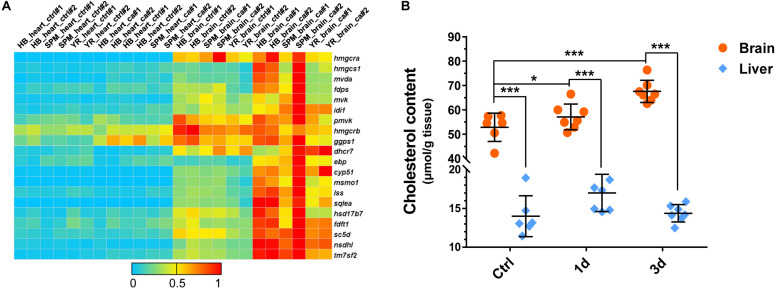
Enhanced total cholesterol accumulation in the brain of common carp during cold acclimation. (A) Up-regulation of genes involved in the cholesterol biosynthesis pathway upon cold stress. The color scale indicates relative gene expression level (ratio to the highest level for each gene). (B) Cold acclimation increased the concentration of total cholesterol in the brain of SPM carp. Data are means ± SD (n = 7); *p < 0.05; ***p < 0.001.